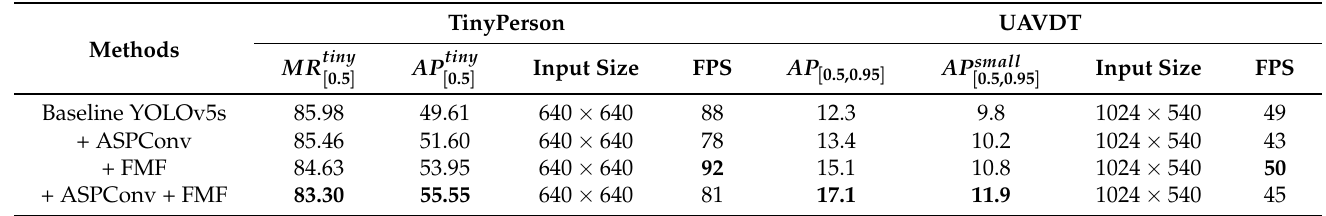
Table 8. Ablation study of ASPConv and FMF on TinyPerson and UAVDT testing datasets, where the batch size and IoU threshold are set to 1 and 0.5, respectively. The best results are marked in bold.